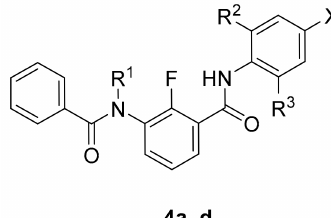
Table 1. Insecticidal activities of SF 5 -containing meta-diamide insecticides 4a – d against the 3rd instar larvae of Plutella xylostella .